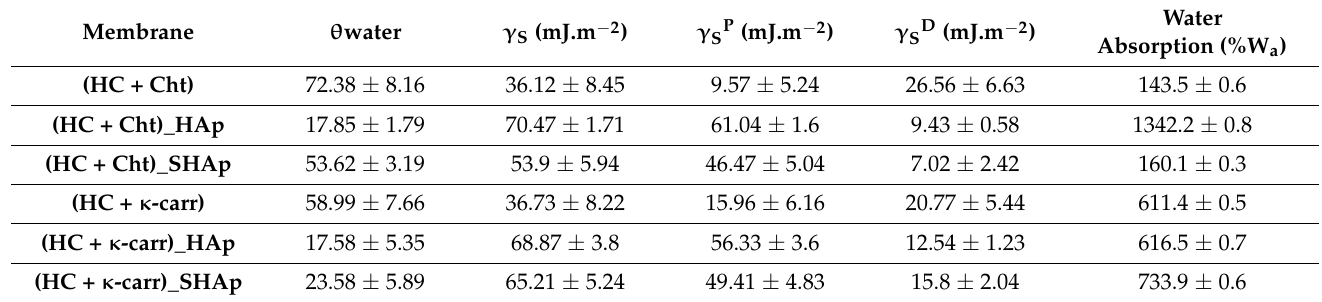
Table 2. Surface properties of biopolymeric and hybrid membranes: wettability ( θ water ), per- centage of water absorption (%W a ), free surface energy ( γ S ), and its dispersive ( γ SD ) and polar ( γ SP )